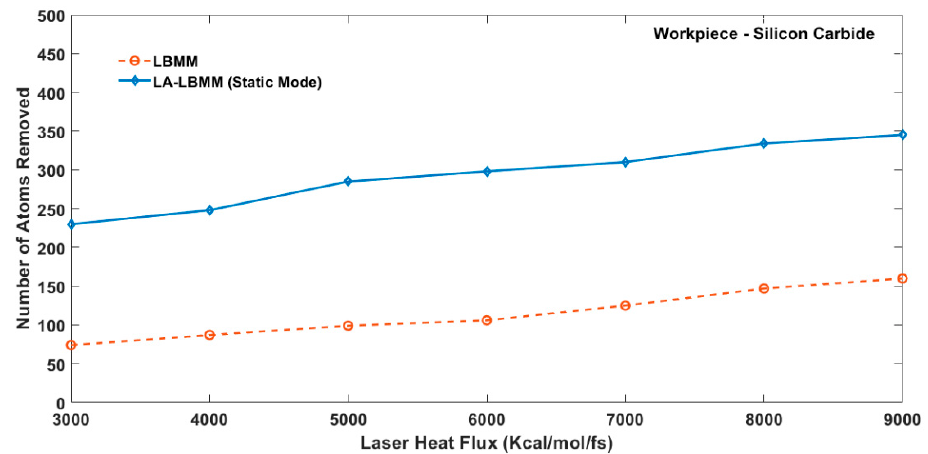
Figure 11. Variation in the Number of Atoms Removed with respect to the Heat Flux during the LBMM and LA-LBMM Process (Static Mode) on the SiC Substrate.